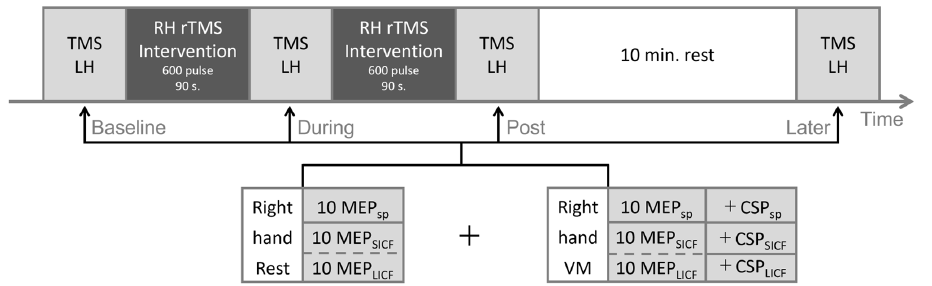
Figure 1. Experimental protocol. Repetitive TMS intervention (real or sham, dark grey) was applied in two sessions with 600 pulses each. TMS measurement (light grey) was performed at four timepoints throughout the experiment. The order of SICF and LICF measurements was randomized for each timepoint, as shown in dashed lines. LH = left hemisphere; RH = right hemisphere; VM = voluntary movement; MEP = motor evoked potential; SICF = short ‐ interval intracortical facilitation; LICF = long ‐ interval intracortical facilitation; CSP = cortical silent period; sp = single ‐ pulse.